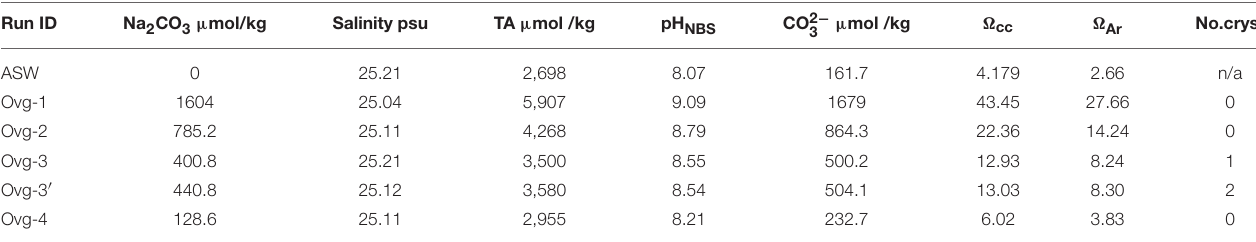
TABLE 1 | Experimental parameters and calculated